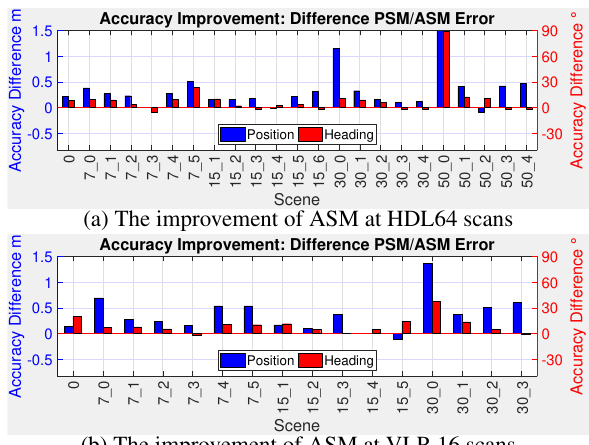
Figure 6. The improvement of the accuracy using the ASM compared to the BC-PCA for the sedan type car scenarios. It shows the underestimation of the car length by the BC-PCA because of the missing scan points at the end of the car by the error parallel (green) and the systematic error orthogonal to the car axis (yellow). The systematic shift towards the scan- ner is also visible in the enlarged image part at the red points in Figure 3. The underestimations of the length are mitigated by the ASMs (Figure 3 blue points), especially the error orthogo- nal to the car axis is reduced. The peaks in the total HDL-64